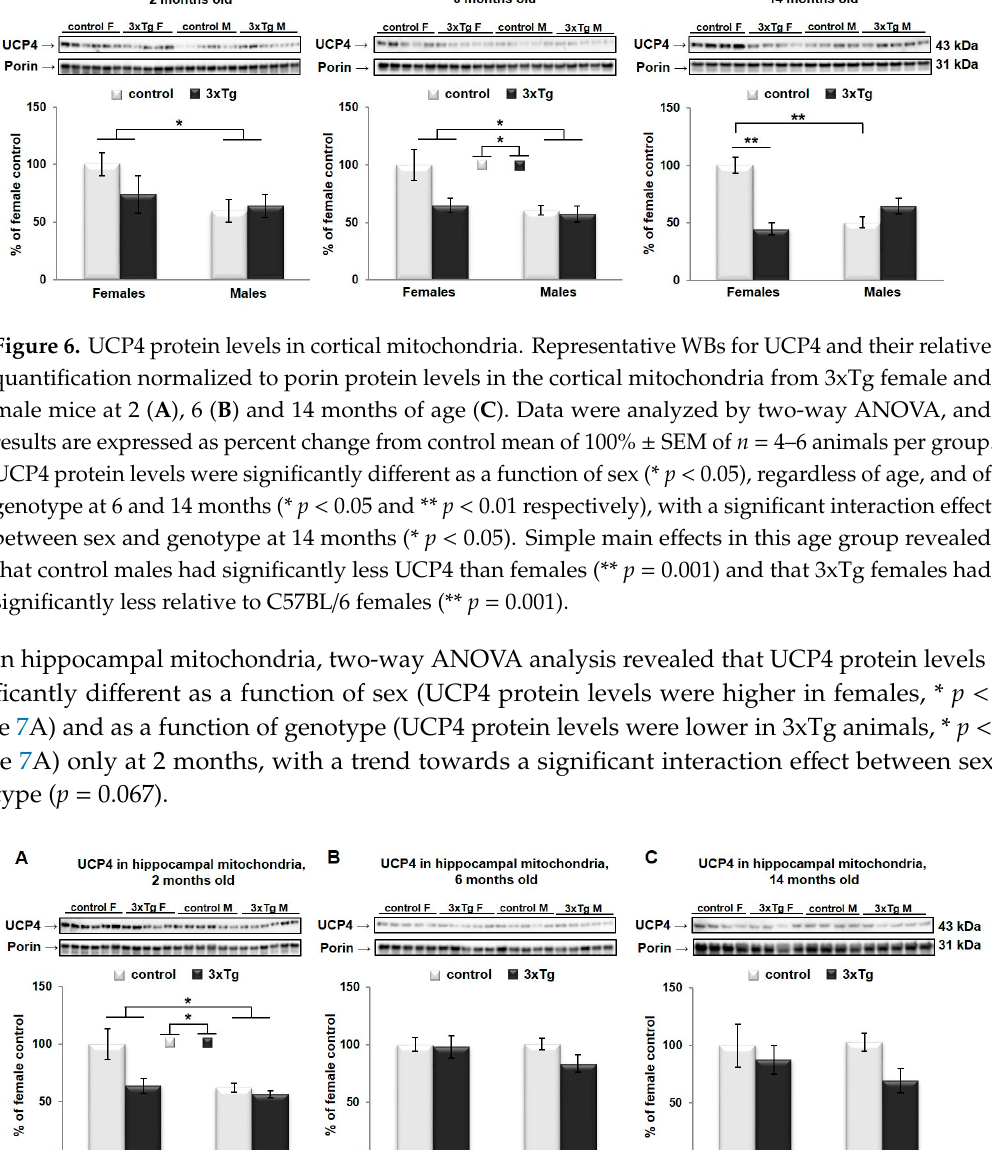
Figure 7. UCP4 protein levels in hippocampal mitochondria. Representative WBs for UCP4 and their relative quantification normalized to porin protein levels in the hippocampal mitochondria from 3xTg female and male mice at 2 ( A ), 6 ( B ) and 14 months of age ( C ). Data were analyzed by two-way ANOVA, and results are expressed as percent change from control mean of 100% ±SEM of n = 4–6 animals per group. UCP4 protein levels were significantly different as a function of sex (* p < 0.05) and as a function of genotype (* p < 0.05) only at 2 months, with a trend towards a significant interaction effect between sex and genotype ( p = 0.067).